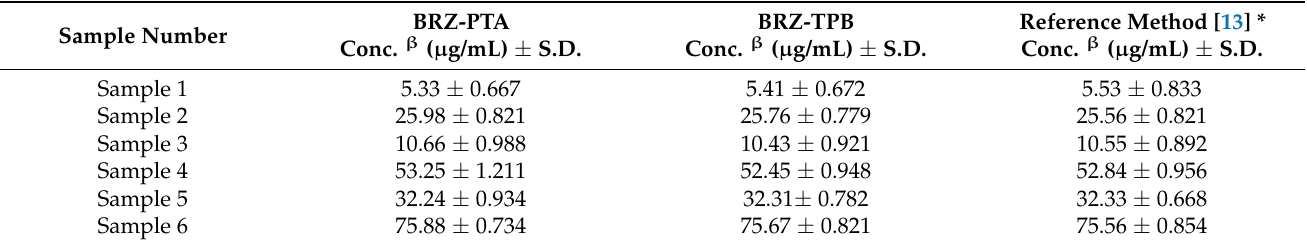
Table 4. Determination of BRZ in actual wastewater samples from pharmaceutical industrial